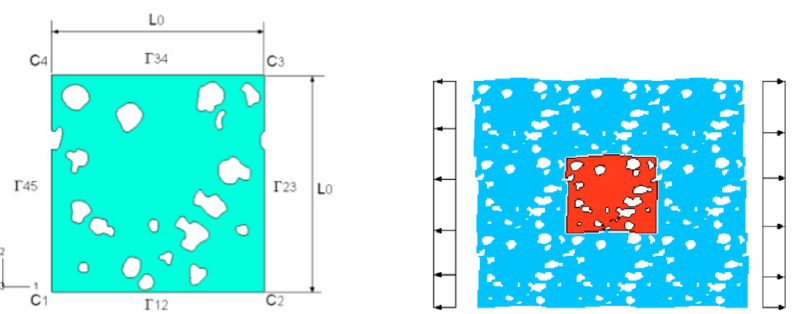
Figura 14: Un modello window con condizioni al contorno opportune può riprodurre un microcampo periodico.